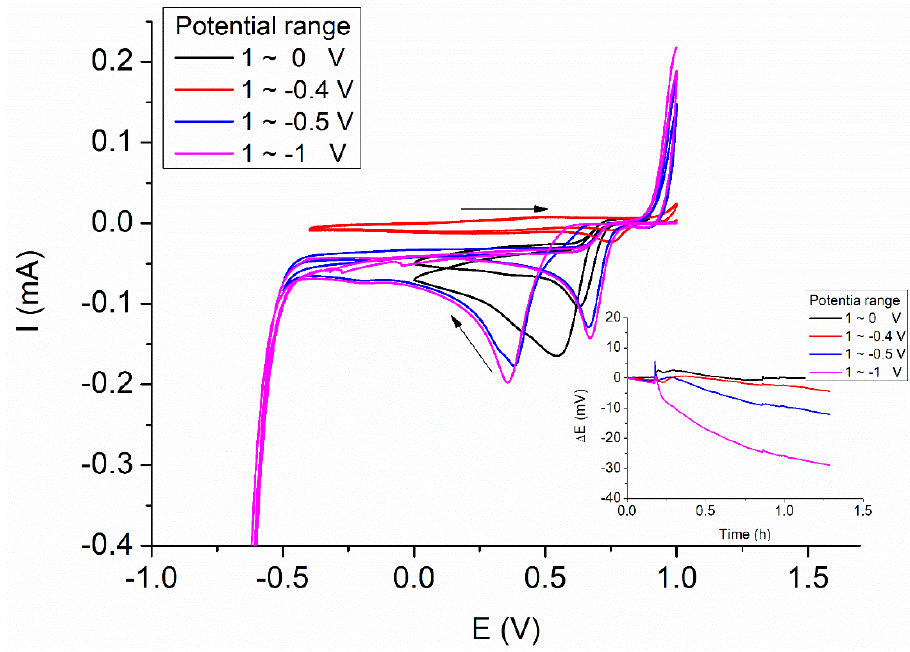
Figure 1. CV plots of AuNPs electrodeposition within di ff erent potential ranges. Scan cycle, 2 cycles; Scan rates, 50 mV s − 1 . Inset: Potentiometric responses of BSA adsorption on the resulting electrodes.